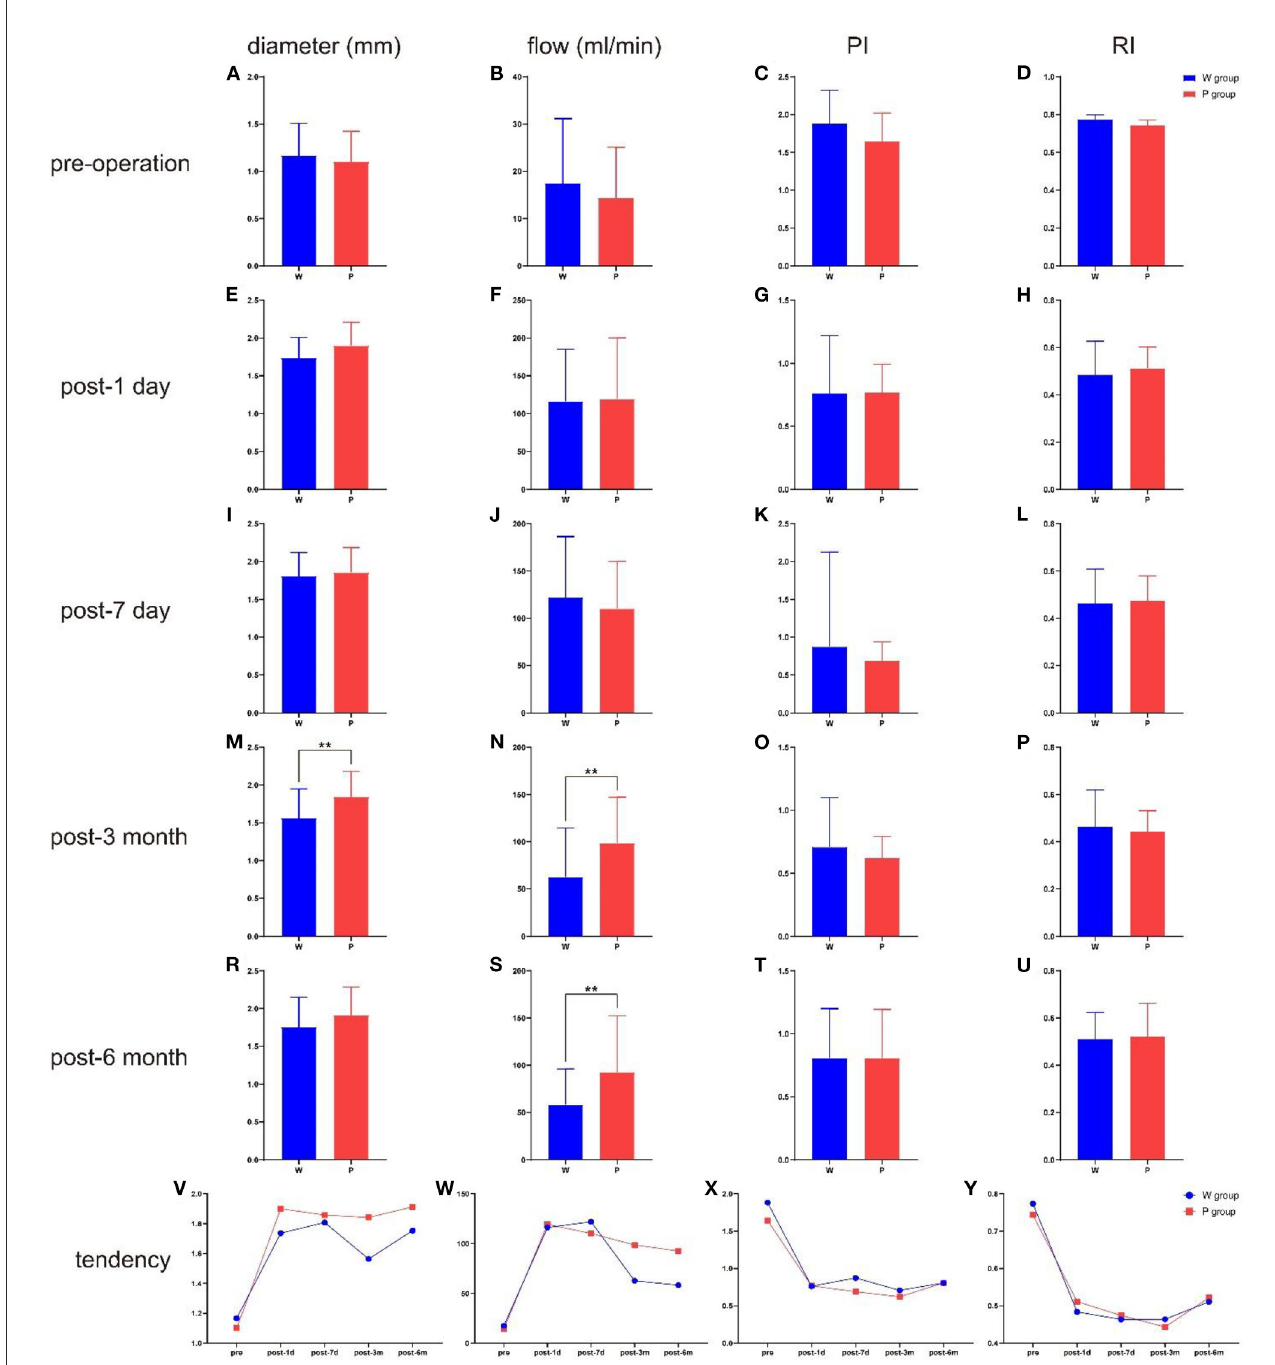
FIGURE2 The comparison of ultrasonographic parameters between the two groups in different time point, and the total tendency of different hemodynamics indicators. (A) The diameter at pre-operation. (B) The flow at pre-operation. (C) The PI at pre-operation. (D) The RI at pre-operation. (E) The diameter at post-operative 1 day. (F) The flow at post-operative 1 day. (G) The PI at post-operative 1 day. (H) The RI at post-operative 1 day. (I) The diameter at post-operative 7 day. (J) The flow at post-operative 7 day. (K) The PI at post-operative 7 day. (L) The RI at post-operative 7 day. (M) The diameter at post-operative 3 month. (N) The flow at post-operative 3 month. (O) The PI at post-operative 3 month. (P) The RI at post-operative 3 month. (R) The diameter at post-operative 6 month. (S) The flow at post-operative 6 month. (T) The PI at post-operative 6 month. (U) The RI at post-operative 6 month. (V) The total tendency of diameter. (W) The total tendency of flow. (X) The total tendency of PI. (Y) The total tendency of RI. ** P < 0.01.